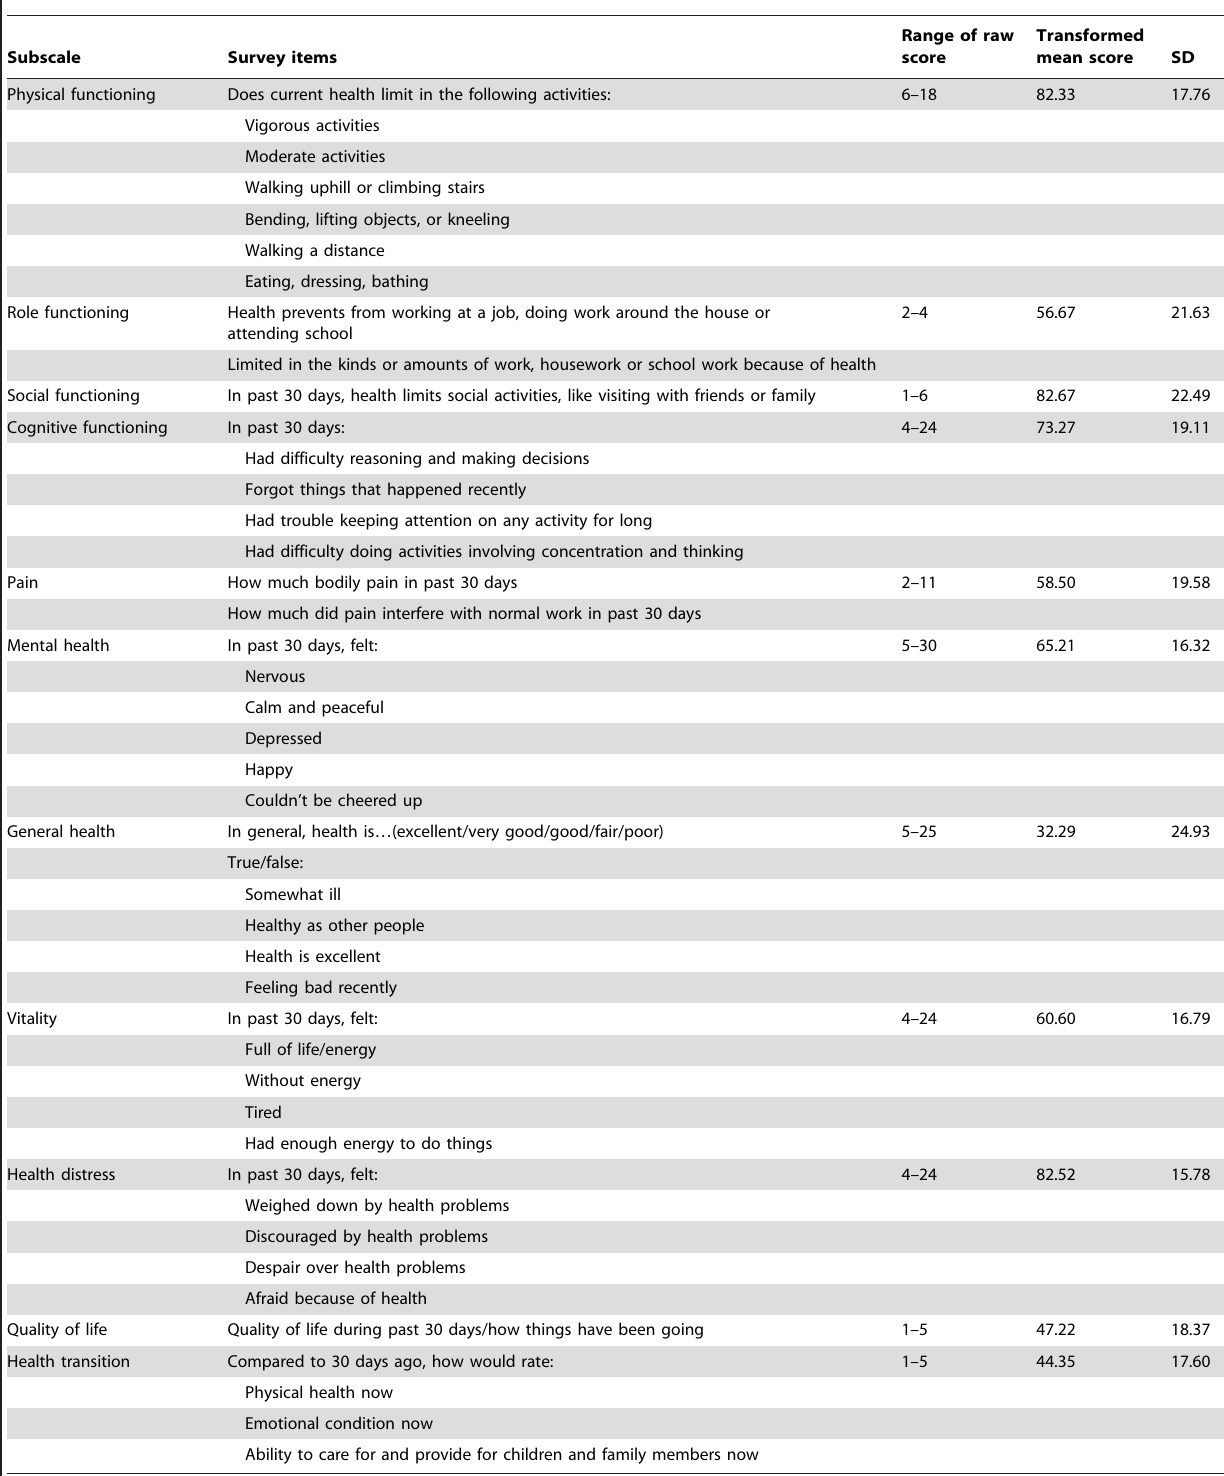
Table 1. Summary of questions used to construct MOS subscales.